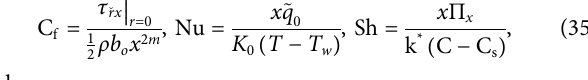
Frontiers in Physics |